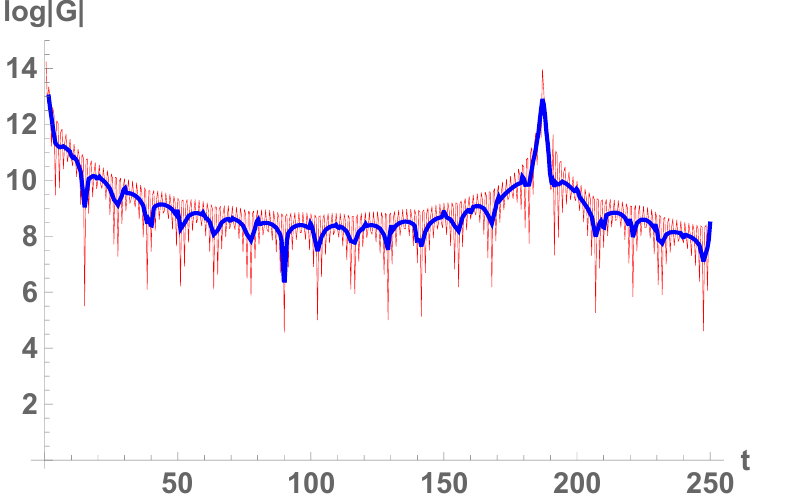
Figure 11. The wormhole correlator G R (∆ t, ∆ ϕ = 0 . 1) as given in (5.17). We take R = r + = 1 , WH λ = 2 · 10 − 20 and (cid:15) = 10 − 1 , and evaluate each of the four sums in (5.17) up to n max = 500 , k max = 50 . The red line is the computed value and the blue line is a smoothed out average. We can clearly see the first recurrence or “echo”, which occur at ∆ t ≈ 2 nL λ ≈ 186 . 98 n